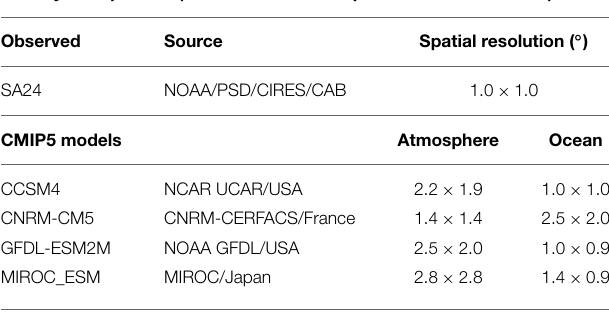
TABLE 1 | Observed and CMIP5 models daily precipitation dataset.